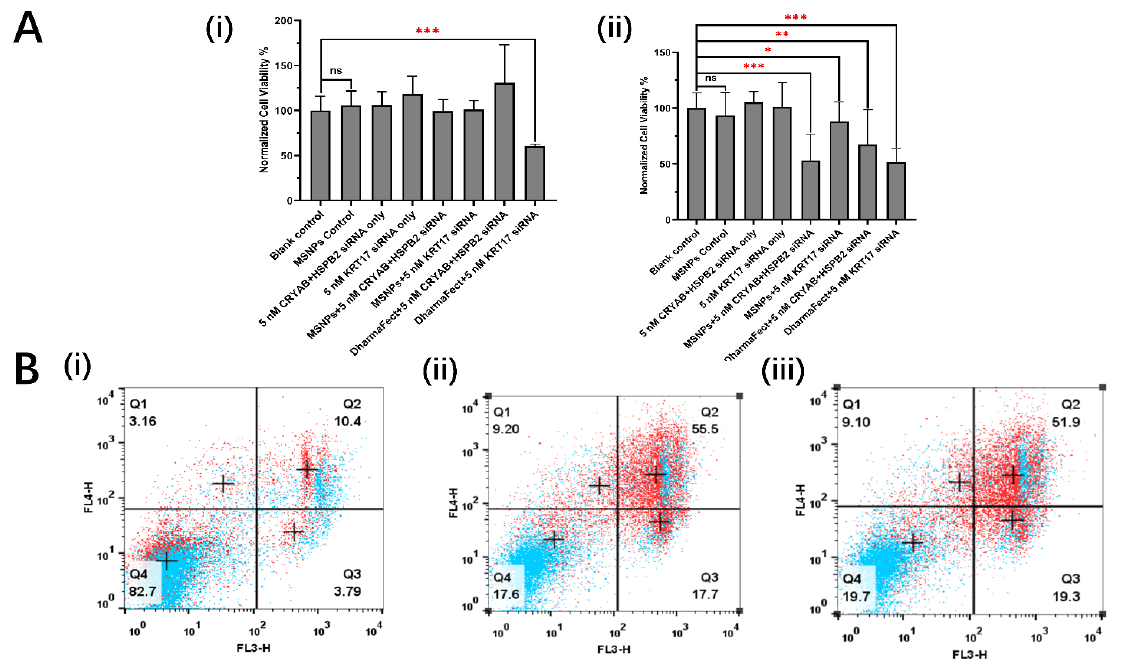
Figure 4. Measurement of siRNA linked MSNPs effects on cell proliferation and mobilities ( A ) MTT results comparing the cell relative survival rate and metabolism level of RD (i) and RH30 (ii) sarcoma cells after treatment with 5 nM of free CRYAB and HSPB2-targeting siRNA, or KRT17-targeting siRNA, or the same concentration transfected by DharmaFect or MSNPs for 24 h ( n = 6). Data are presented as mean ± SD for each individual cell line ( n = 3). Significance was tested using a two tailed t-test compared to the cells with only buffers for each cell line (ns: not significant, * p ≤ 0.05, ** p ≤ 0.01, *** p ≤ 0.001). ( B ) APC-Annexin V and PI assay results measuring the cell apoptosis and necrosis RH30 sarcoma cell spheroids with SH-MSNPs control (i), 50 nM of CRYAB and HSPB2-target siRNA linked MSNPs (ii), and 50 nM of KRT17-target siRNA linked MSNPs (iii) for 72 h. Control groups: blue; treatment groups: